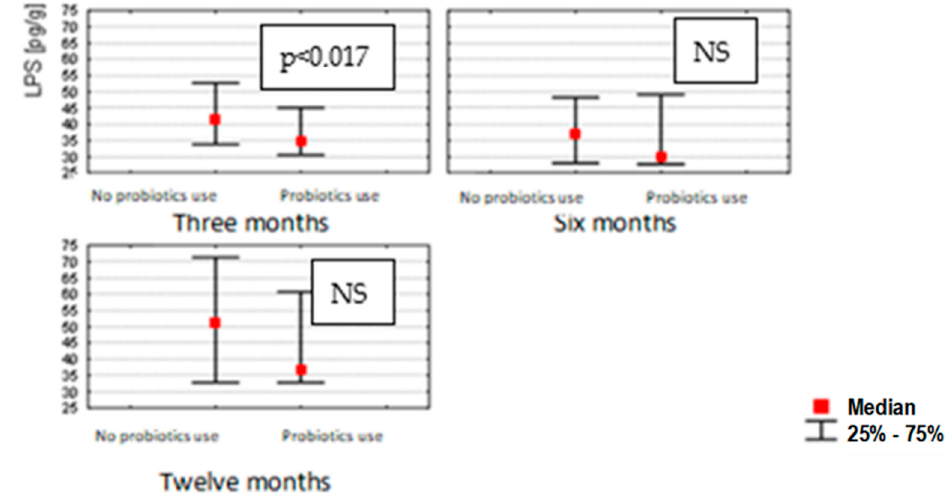
Figure 4. LPS concentrations in stools of 3 ( n = 96), 6 ( n = 90) and 12 ( n = 84) month-old children, depending on probiotic application after birth. (Mann–Whitney U test and Kruskal–Wallis test; a p -value ≤ 0.05 was considered statistically significant. NS: non-significant ).